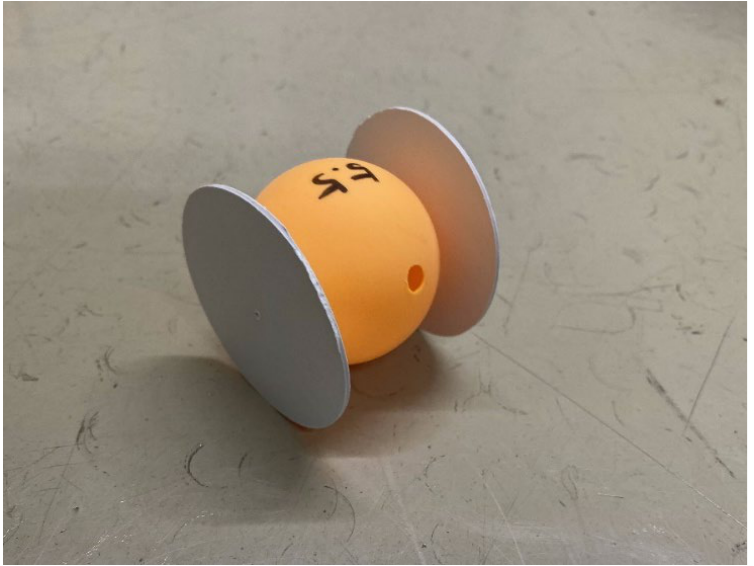
Figure 6. Appearance of a ball between wheels (The diameter of the ball is 44 mm. The wheel diameter is 54 mm. Its weight is 5.5 g.). The speaker is first set 3.5 cm apart from the actuator. The speaker used in the experiment is a powered speaker MoniOne made by Classic Pro. The sound volume at the actuator point was 131.7 dBA. The room temperature was 10.4 ◦ C and the maximum wind speed was 6.01 m/s at 730 Hz. The experimental method was to apply a sound of 730 Hz to each of the four structures and observe how they